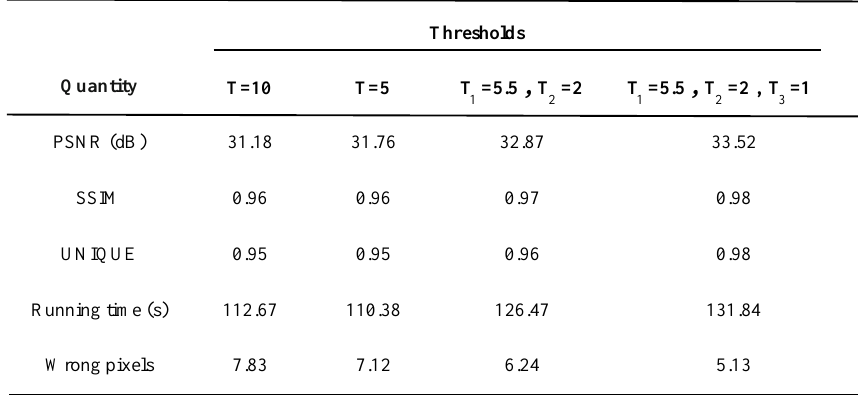
Table 5. Objective measures of virtual view by the proposed method for "Art"